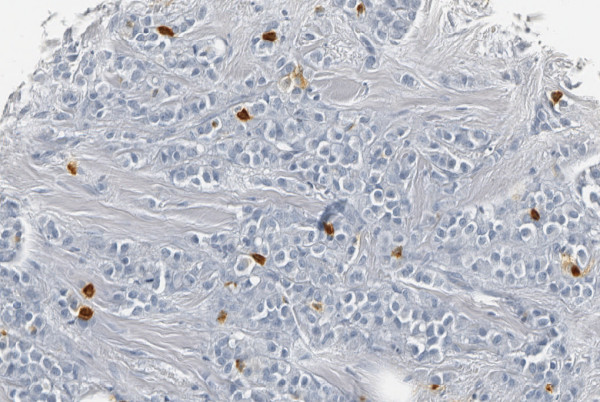
Mast cells express a dark brown immunoreactivity in the cytoplasm.